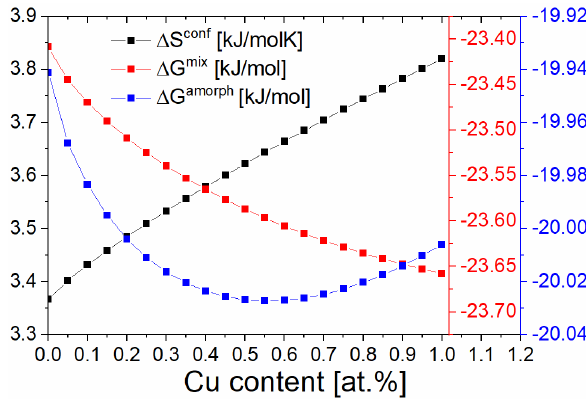
Figure 1. Dependencies of thermodynamic parameters as a function of Cu content.